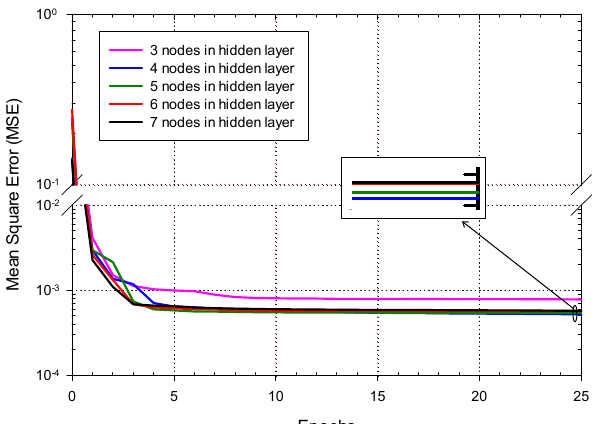
Figure 6. Convergence of the proposed ANN predistorter with different nodes in the hidden layer.